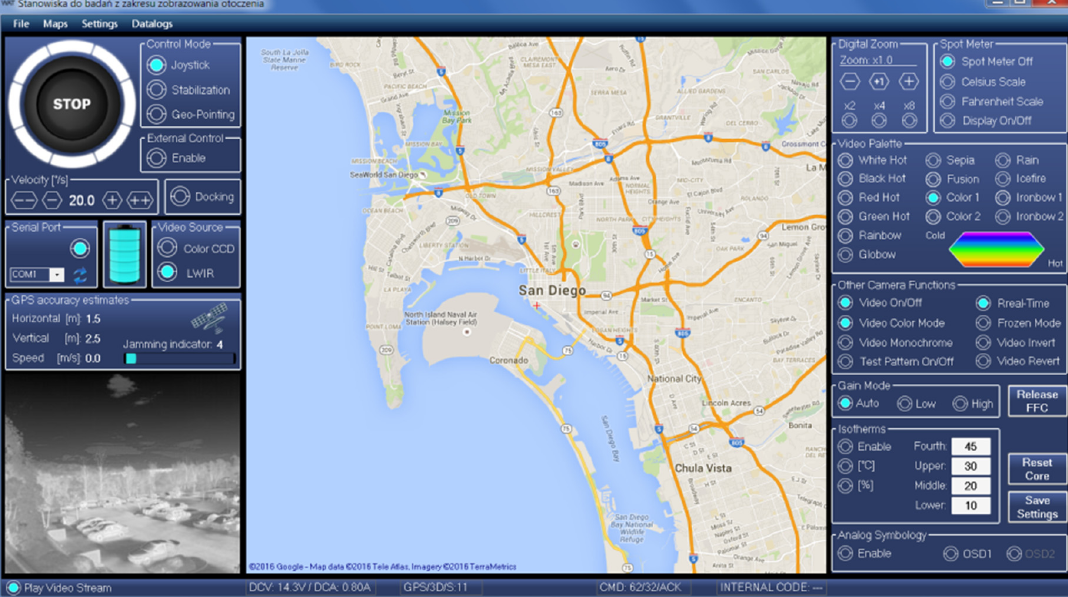
Figure 7. Optoelectronic head control software interface.